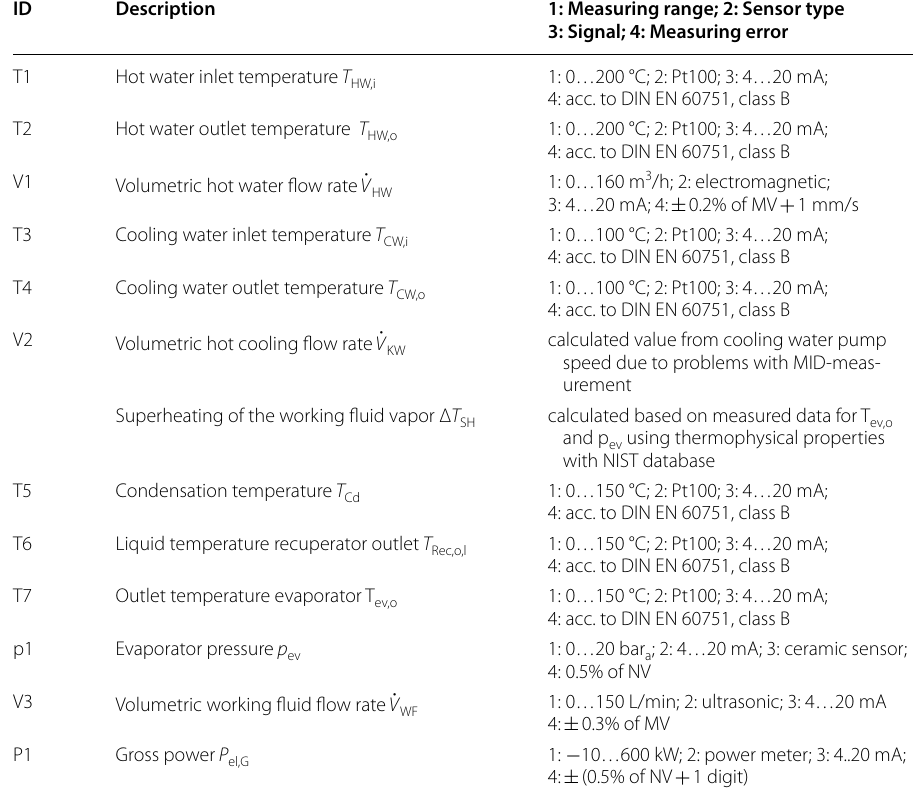
Table 5 Instrumentation and sensor